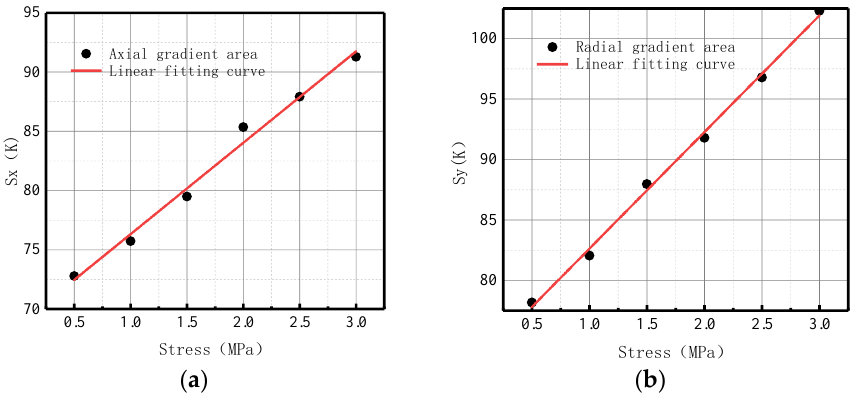
Figure 29. Variations of S ( K ) at the weld under different internal pressures. ( a ) Axial component of S ( k ); ( b ) radial component of S ( k ).